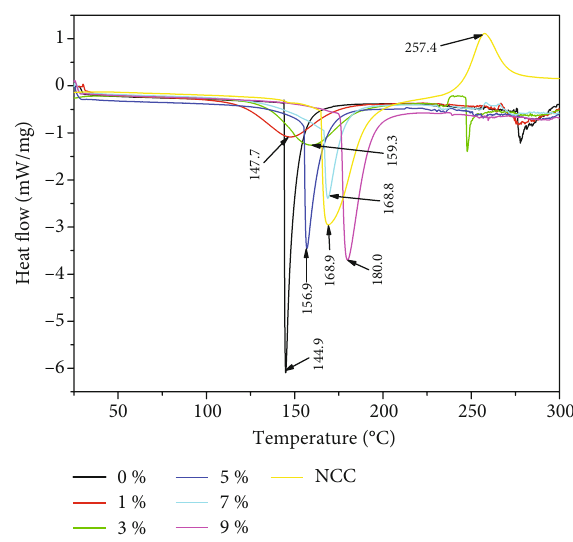
Figure 7: E ff ect of the C-NCC content on the DSC of the composite fi